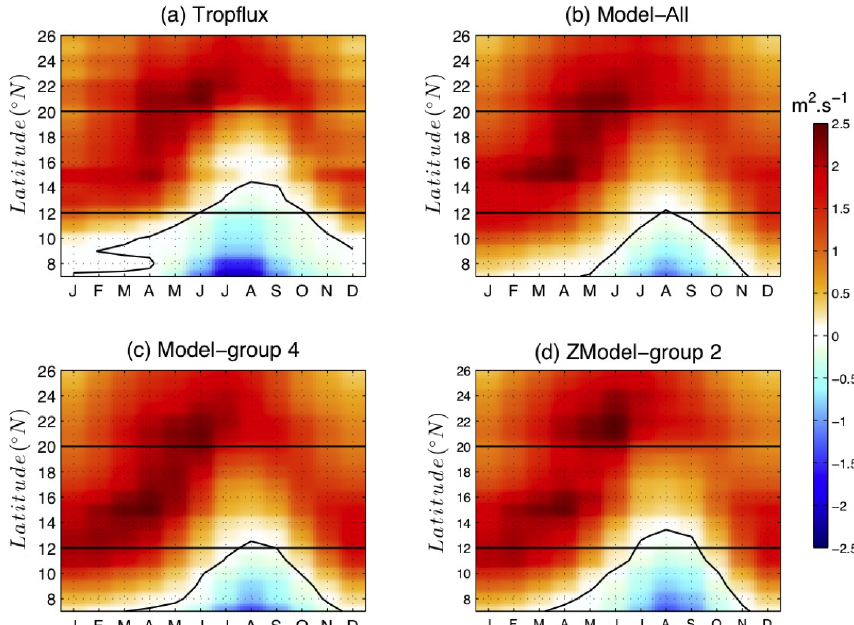
Figure 11. Latitude–time plot of depth-integrated Ekman transport computed over the grid point located along the coast (magenta stars in Fig. 9a). The time axis shows climatological months over the period 1985–2005. Positive (negative) values correspond to upwelling (downwelling) conditions. Panel (a) stands for the TropFlux data set (see Praveen Kumar et al., 2011) (b) Model-All, (c) Model-group 4 and (d) ZModel-group 2. In each panel, the black contour shows the contour zero. The horizontal dashed lines are positioned at 12 and 20 ◦ N and give a rough delimitation of the Senegalo-Mauritanian upwelling region.